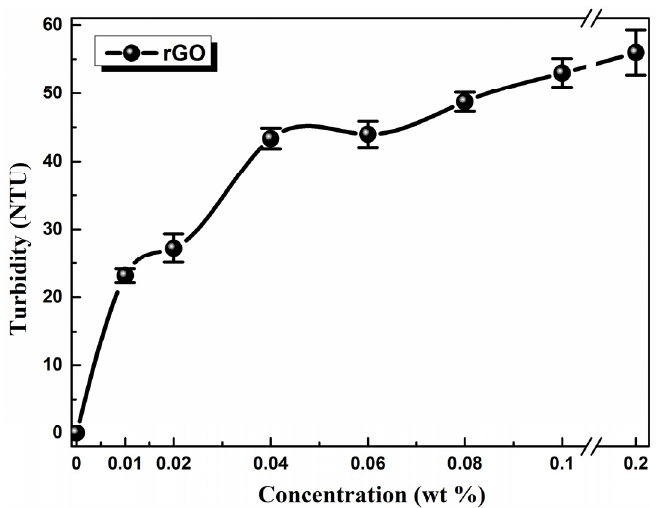
Figure 4. Turbidimetry measurements of the reference 5W-40 engine oil and the prepared dispersions containing rGO as additive from 0.2% to 0.01 wt %. The line is to guide the eye.